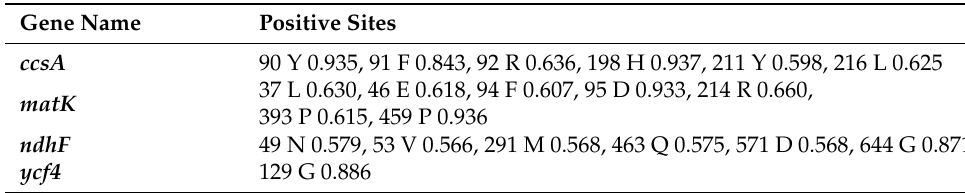
Table 2. Positive selection sites in four Anubias